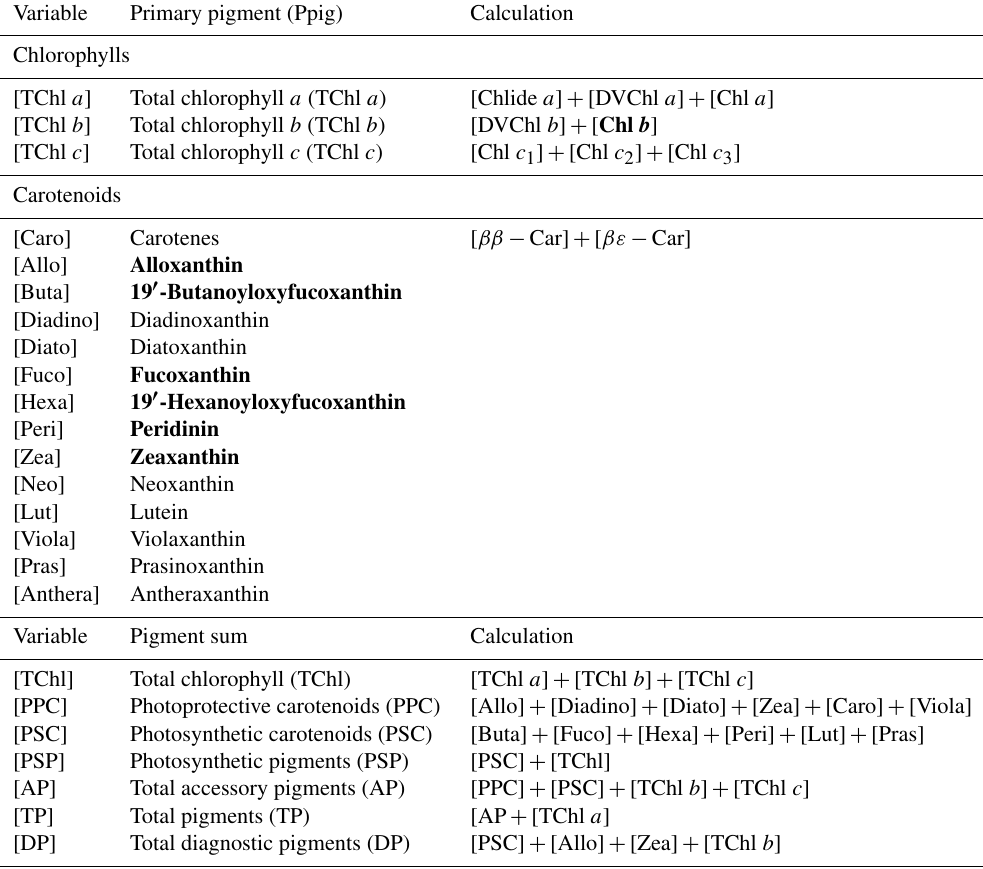
Table 1. Pigment information acquired from HPLC samples in Galveston Bay. Diagnostic biomarker pigments are marked in bold.